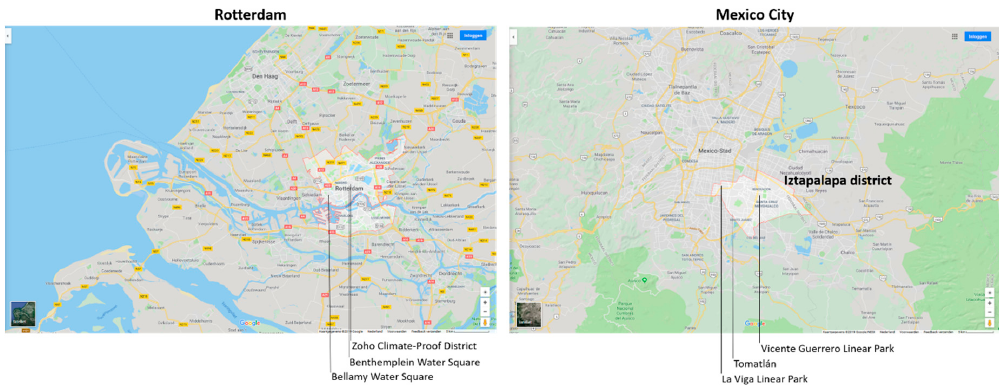
Figure 1. Locations of the water squares in Rotterdam ( left ) and proposed locations in Mexico City ( right ) (map source: Google Maps).